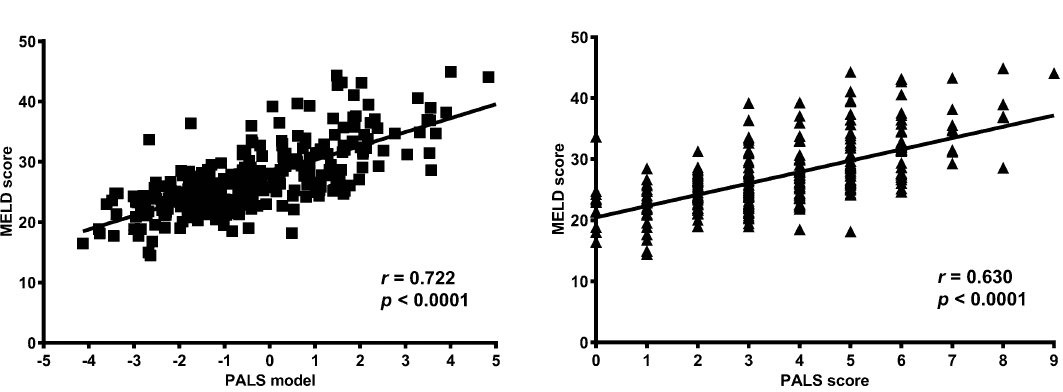
Figure 4. Correlation between PALS model, PALS score and disease severity in derivation cohort. PALS model and PALS score are positively correlated with disease severity rated by MELD score in derivation cohort. MELD model for end-stage liver disease, PALS model predictive model of short-term prognosis for patients treated with artificial liver support system therapy, PALS score predictive score of short-term prognosis for patients treated with artificial liver support system therapy.